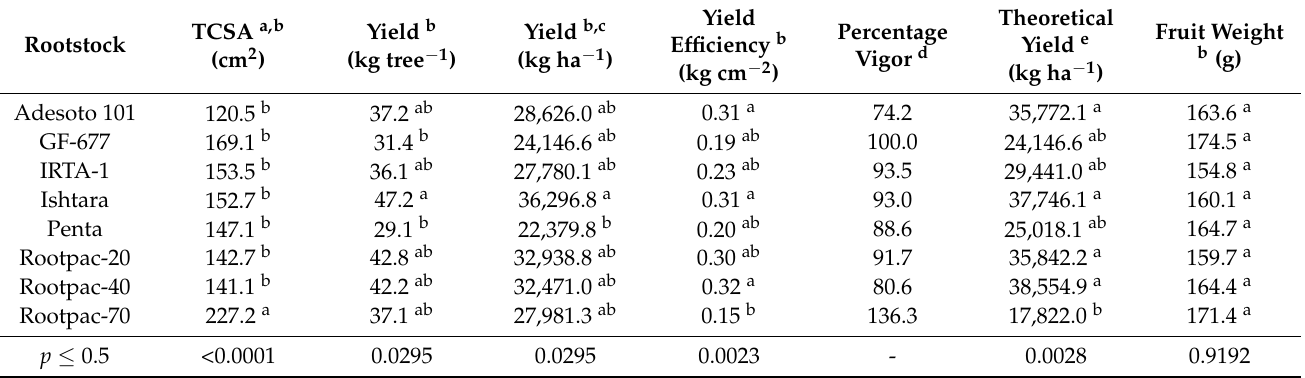
Table 5. Agronomical data at harvest for ‘Big Top’ nectarine cultivar grafted onto eight different Prunus rootstocks at the IRTA’s Lleida Experimental Station (Gimenells, Lleida) in the tenth crop year (2017).